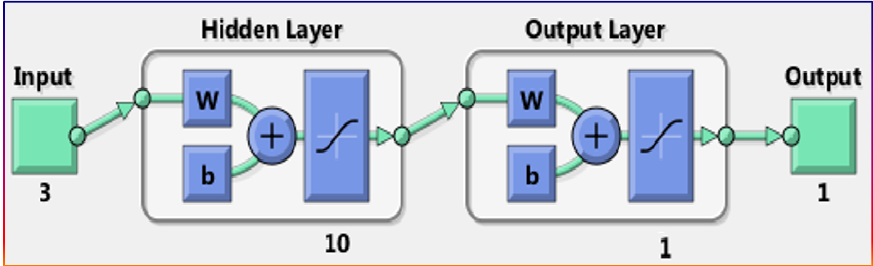
Figure 6. ANN configuration model for this work.